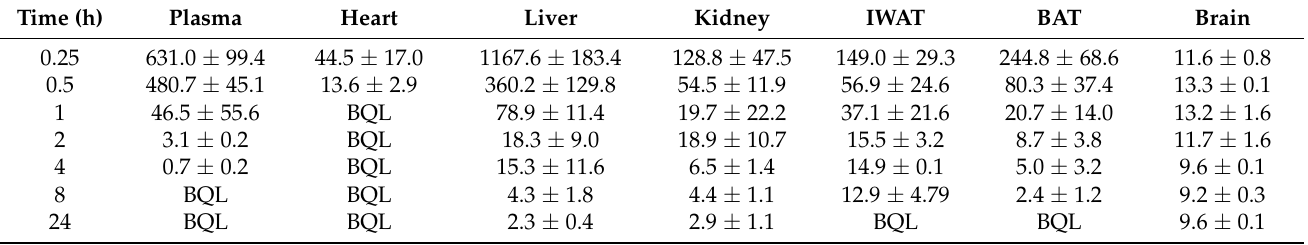
Table 6. Concentration of 13 C 4 SA in plasma (ng/mL) and tissues (ng/g) after a single PO administra- tion (100 mg/kg, mean ± SD, n =